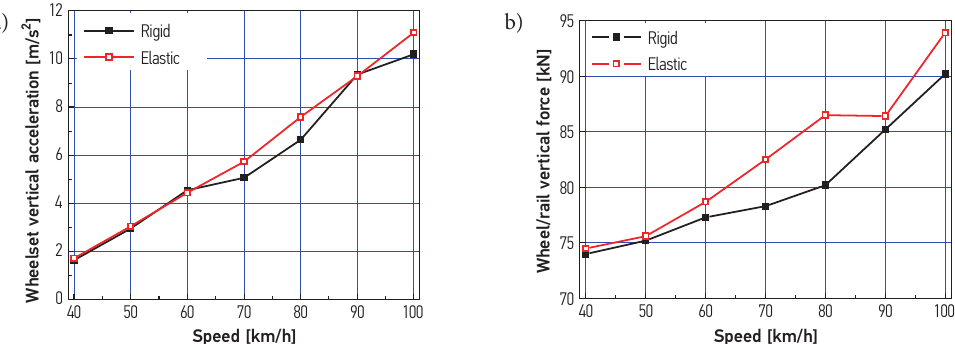
Fig. 13. The wheelset absolute maximum vertical vibration acceleration and the wheel / rail absolute maximum vertical force under different speeds: a – wheelset vertical acceleration; b – wheel / rail vertical force